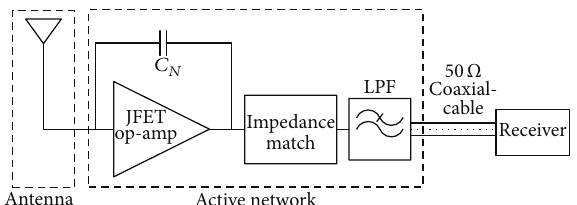
Figure 4: Block diagram of the active antenna.